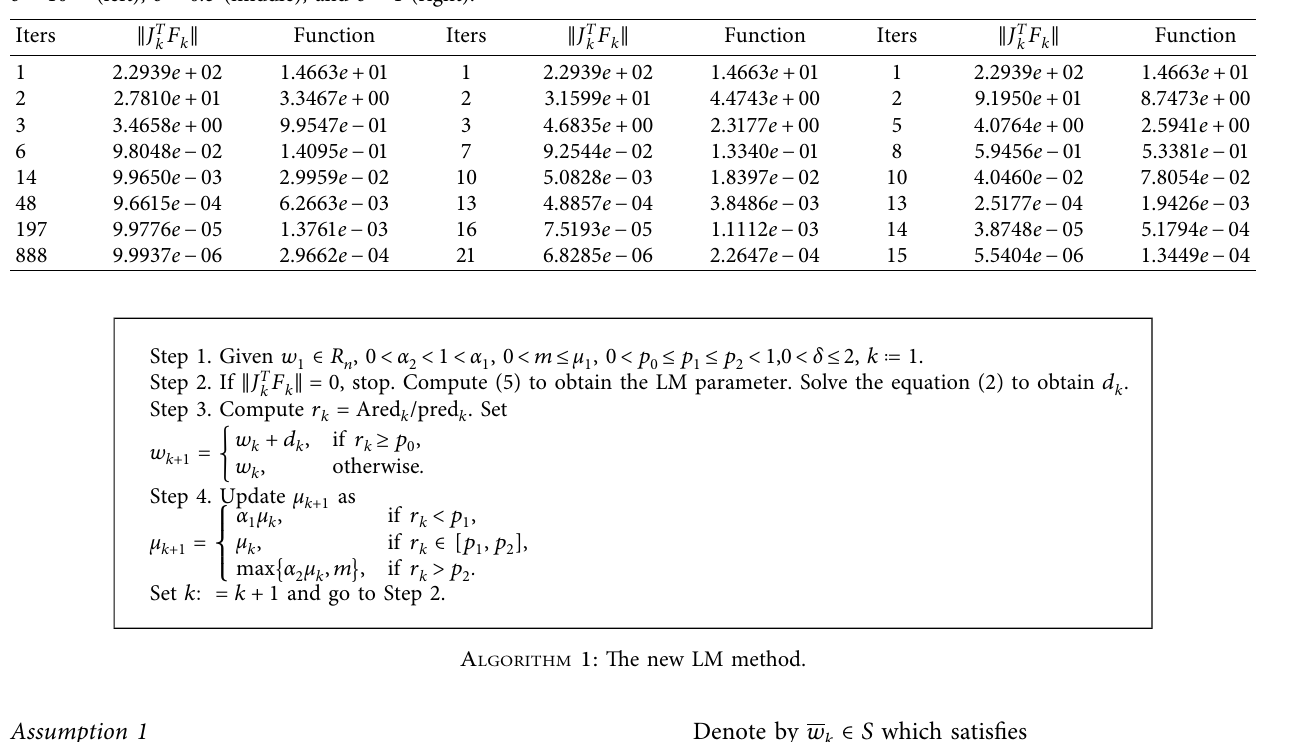
� ( 1 , − 3 , 0 , 1 ) T , stopping criterion ‖ J T 0